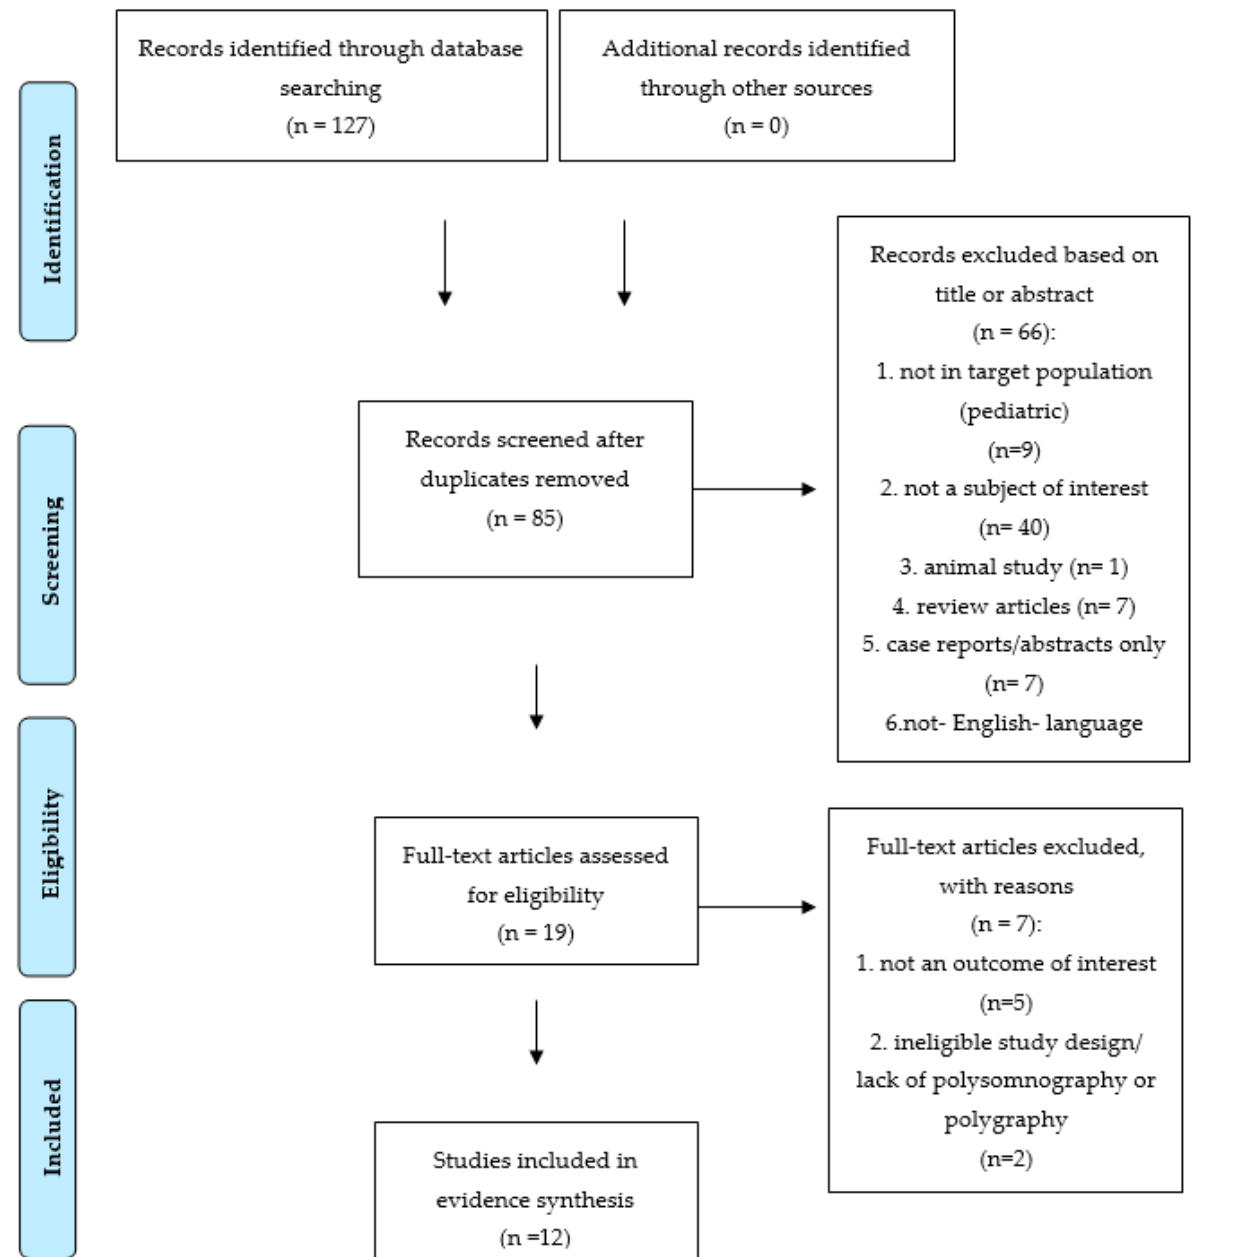
Figure 1. PRISMA (Preferred Reporting Items for Systematic Reviews and Meta-Analyses) flow chart of the review proto- col. Table 1. The main characteristics of the revised studies.